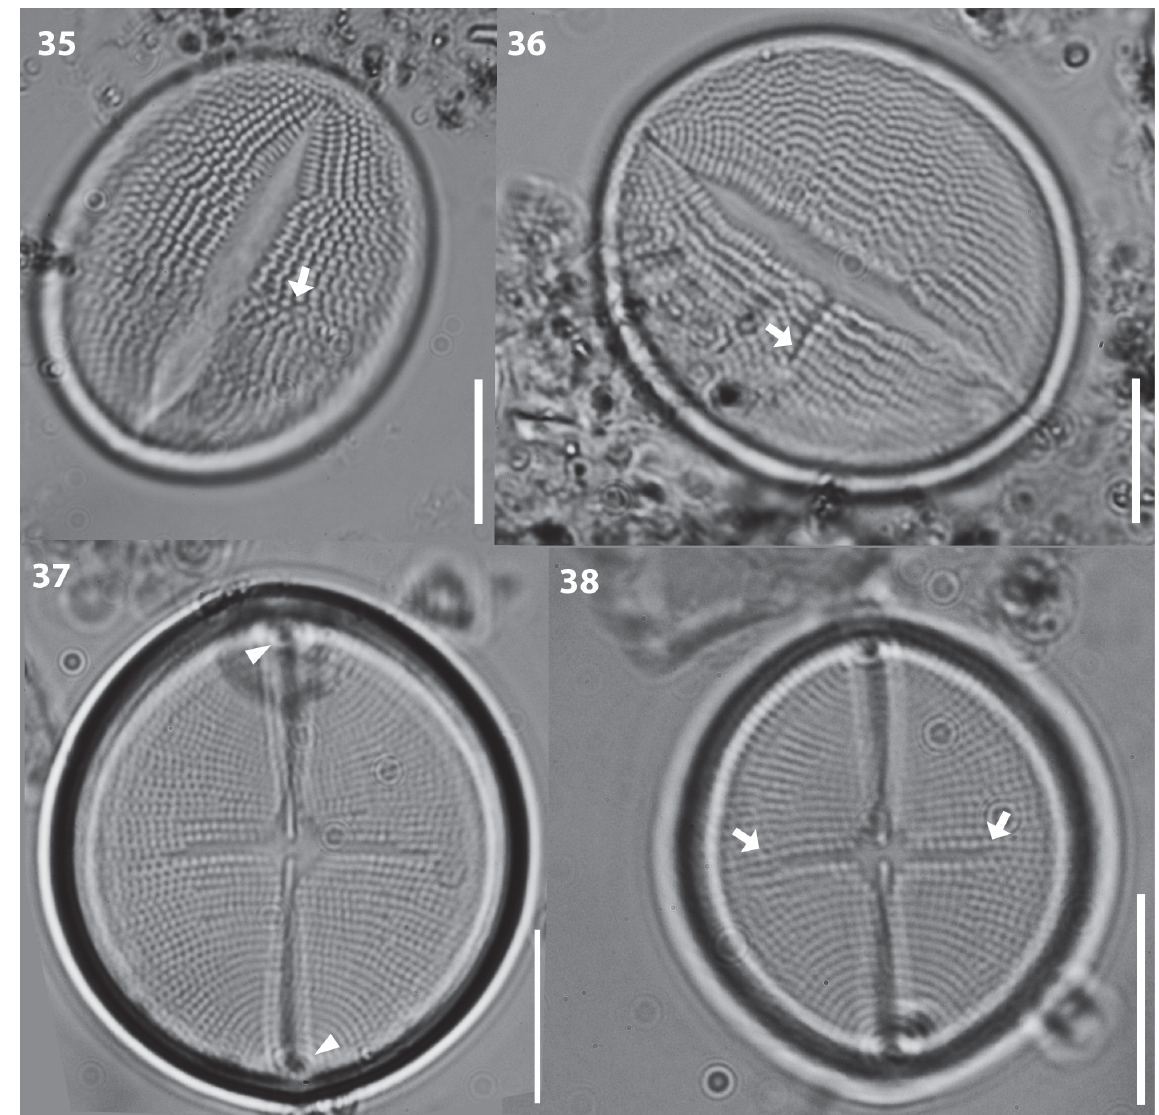
Figs 35–38. Cocconeis dirupta W.Greg. from BM 1420. 37 . Lectotype illustration. SV sternum lanceolate with apices slightly bent in opposite directions (36), one SV stria lacking on one side (35, 36, arrow), RV striae strongly radiate, RV fascia narrow and extended (38, arrows), helictoglossae deflected in opposite directions (37, arrowheads) and raphe slightly sigmoid (37). Scale bars = 10